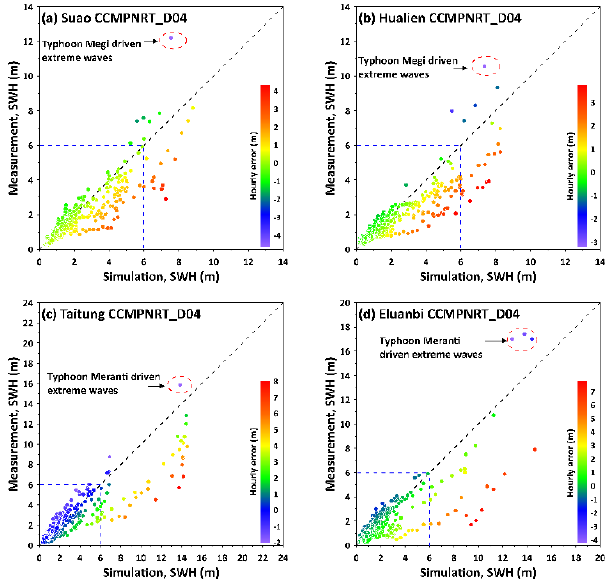
Figure 3. Hourly differences in significant wave height between the measurement and simulation data for the ( a ) Suao, ( b ) Hualine, ( c ) Taitung, and ( d ) Eluanbi wave buoys employing D04 (domain 04) and the SCHISM-WWM-III with CCMPNRT winds.